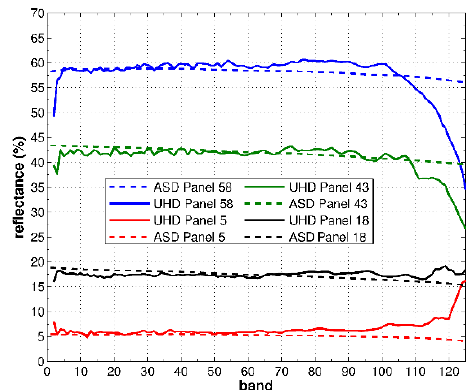
Figure 7. Comparison of the resampled ASD spectra (dashed) with the UHD spectra (solid) of band 1 to 125 for four spectral panels (5, 18, 43 and 58 percent reflectance).